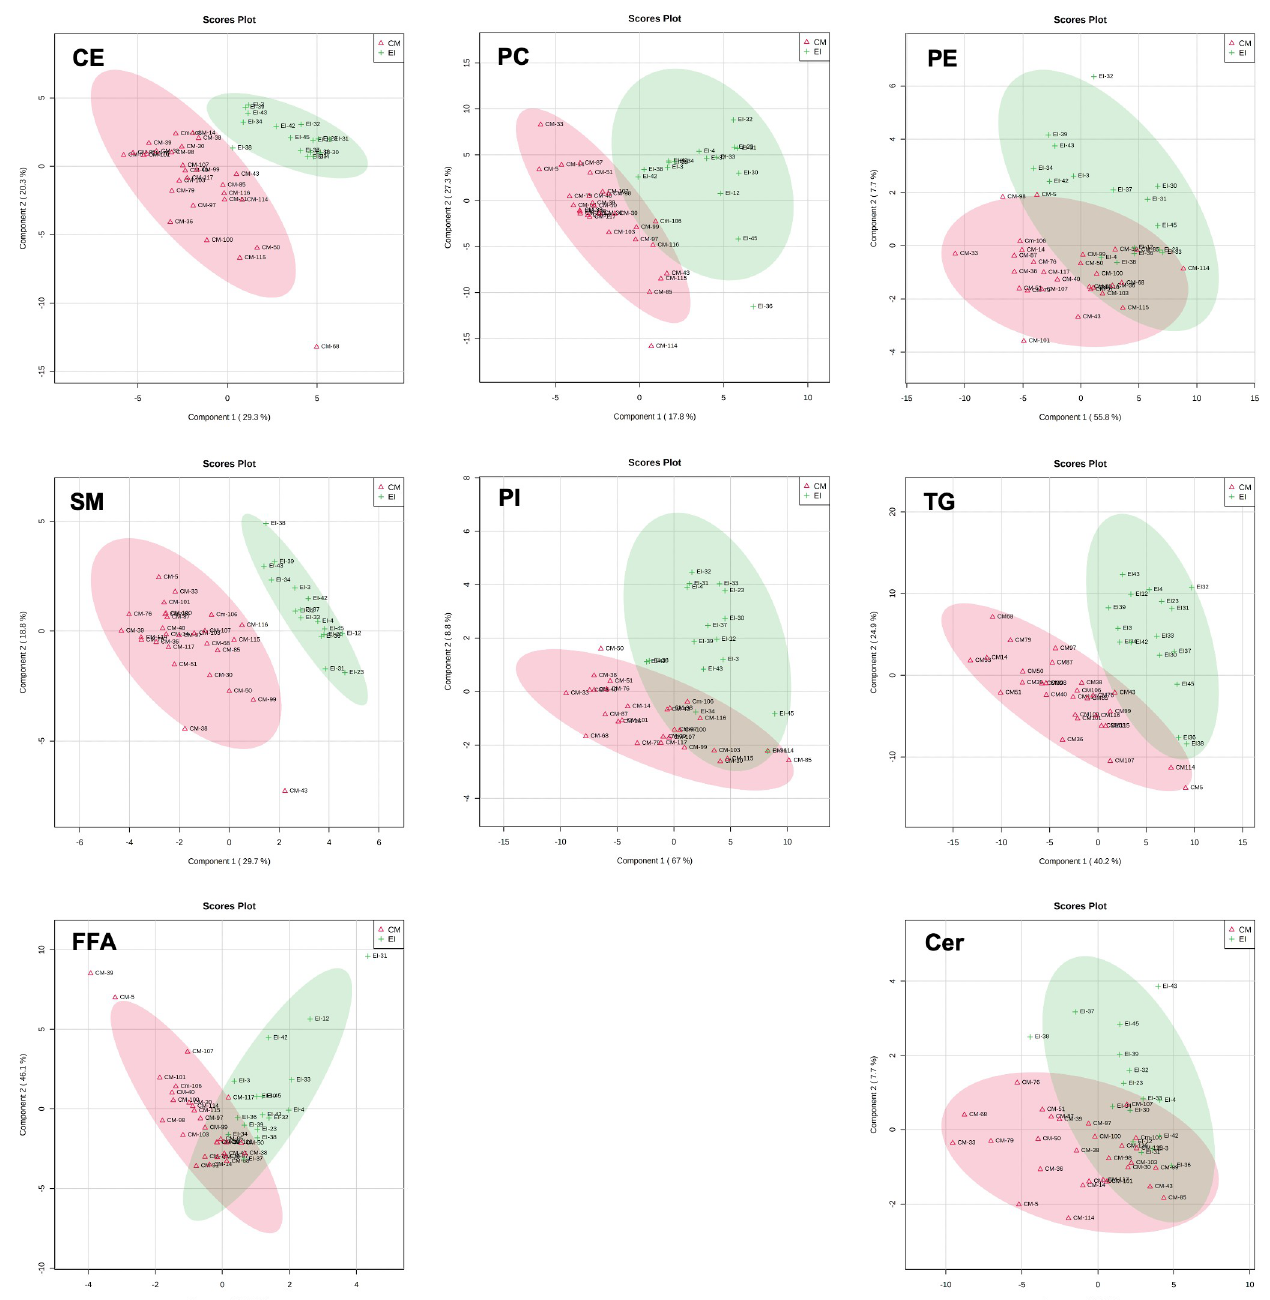
Fig 3. Partial least-squares discriminant analysis of species clusters by plasma lipid profiles. Partial least-squares discriminant analysis (PLS-DA) component 1 (x-axis) and component 2 (y-axis) demonstrating species clusters as a result of plasma lipid profile in green turtles (CM, red triangle) and hawksbill turtles (EI, green plus sign). We live captured all turtles in North Pacific Costa Rica in 2017. Abbreviations: CE = cholesteryl ester; PC = phosphatidylcholine; PE = phosphatidylethanolamine; SM = sphingomyelin; PI = phosphatidylinositol; TG = triacylglyceride; Cer = ceramide; FFA = free fatty acids; PG = phosphatidylglycerol; PS = phosphatidylserine; Car = acyl-carnitine. https://doi.org/10.1371/journal.pone.0253916.g003 green, loggerhead ( Caretta caretta ), and leatherback sea turtles ( Dermochelys coriacea ), we pre- dict that our data are applicable to other sea turtle species foraging in other environments throughout world [8, 59].